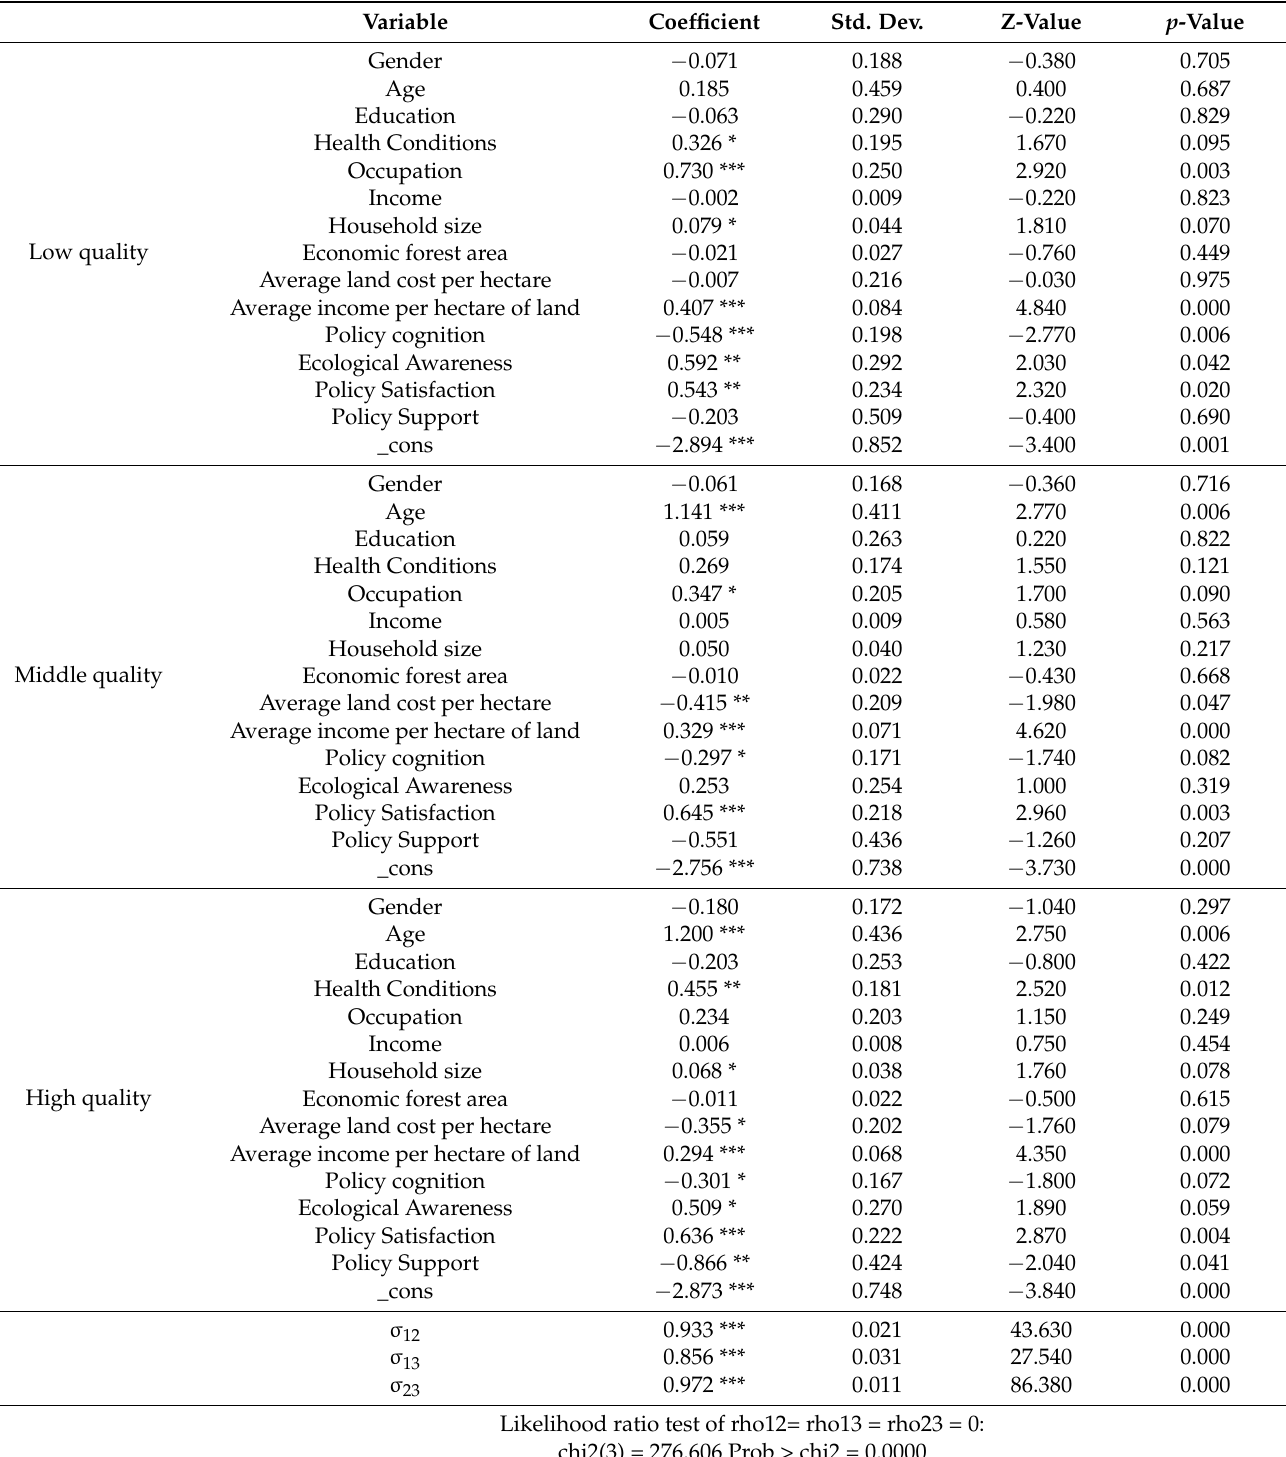
Table 6. MVP model